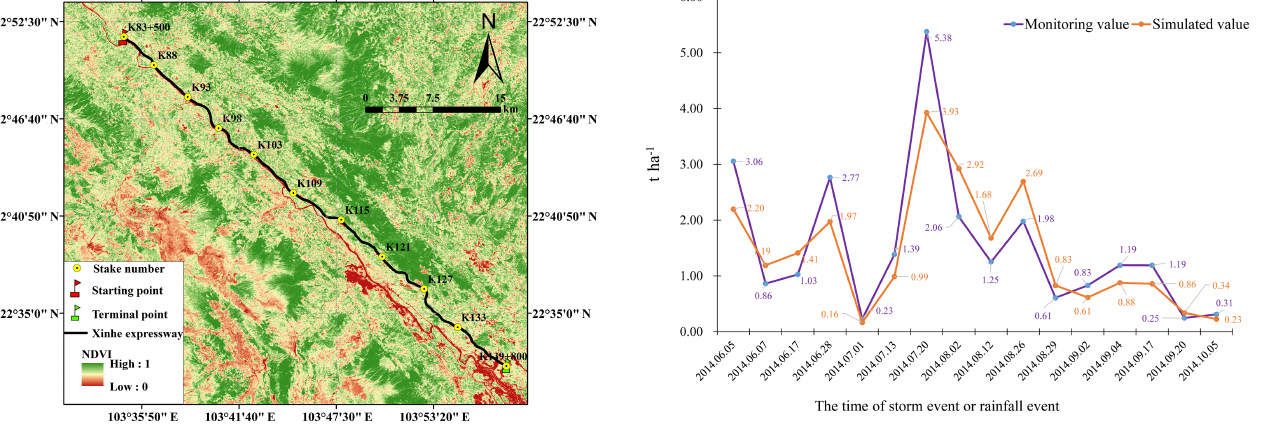
Figure 8. Vegetation coverage along Xinhe Expressway.